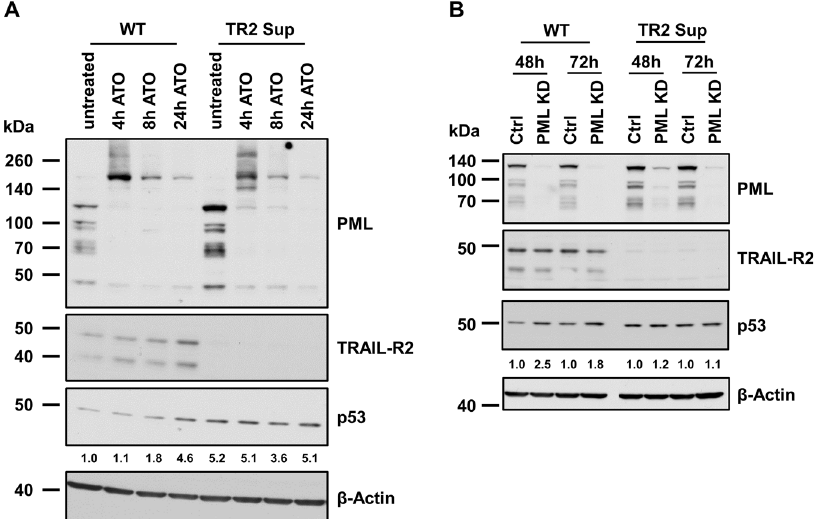
Fig. 7 TRAIL-R2-mediated decrease of p53 stability depends on PML. A A549 WT and TRAIL-R2 Sup cells were treated with Arsenic trioxide (ATO; 5 µM) for indicated time periods. The expression of PML, TRAIL-R2 and p53 was analyzed in whole cell lysates by western blotting. B A549 WT and TRAIL-R2 Sup cells were transiently transfected with PML siRNA (PML KD) or control siRNA (Ctrl). Protein levels of PML, TRAIL- R2, and p53 were analyzed by western blotting 48 h and 72 h after transfection. The level of β -Actin was determined in parallel and served as loading control. P53 protein level was quanti fi ed by densitometry and normalized to β ‐